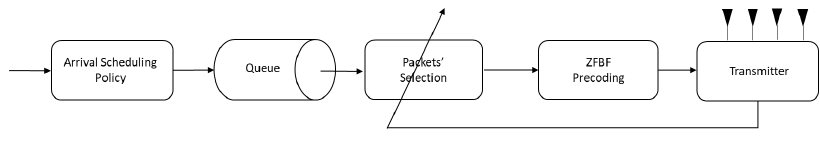
Figure 3. RPS policy packet